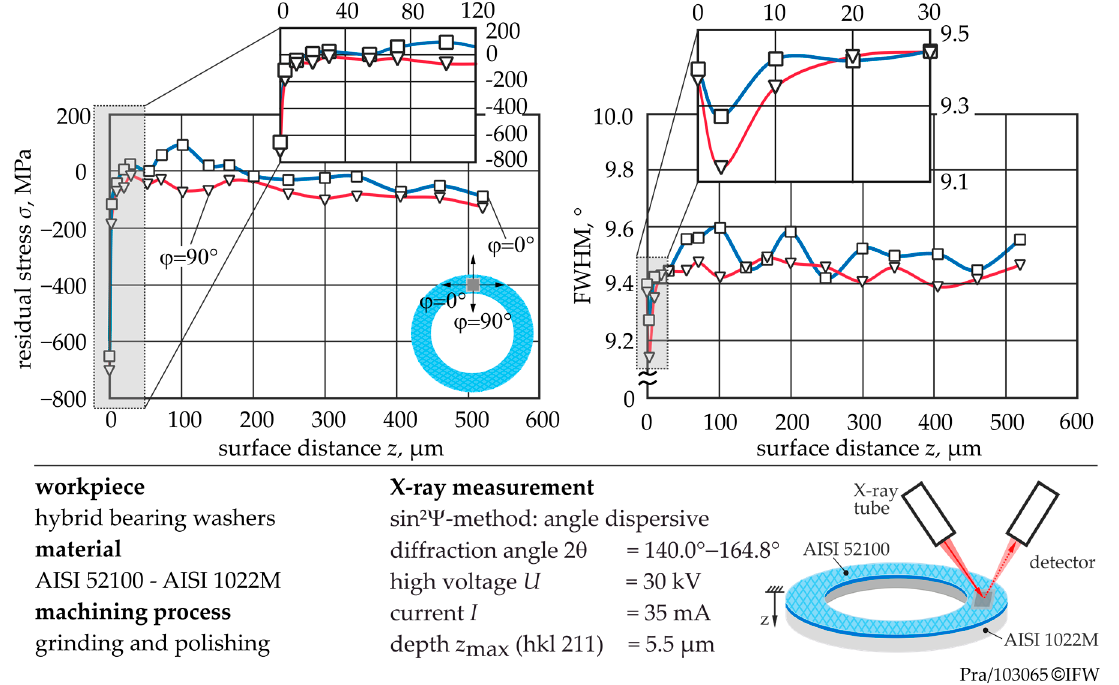
Figure 10. Residual stress and full width at half maximum (FWHM) depth profile after machining.